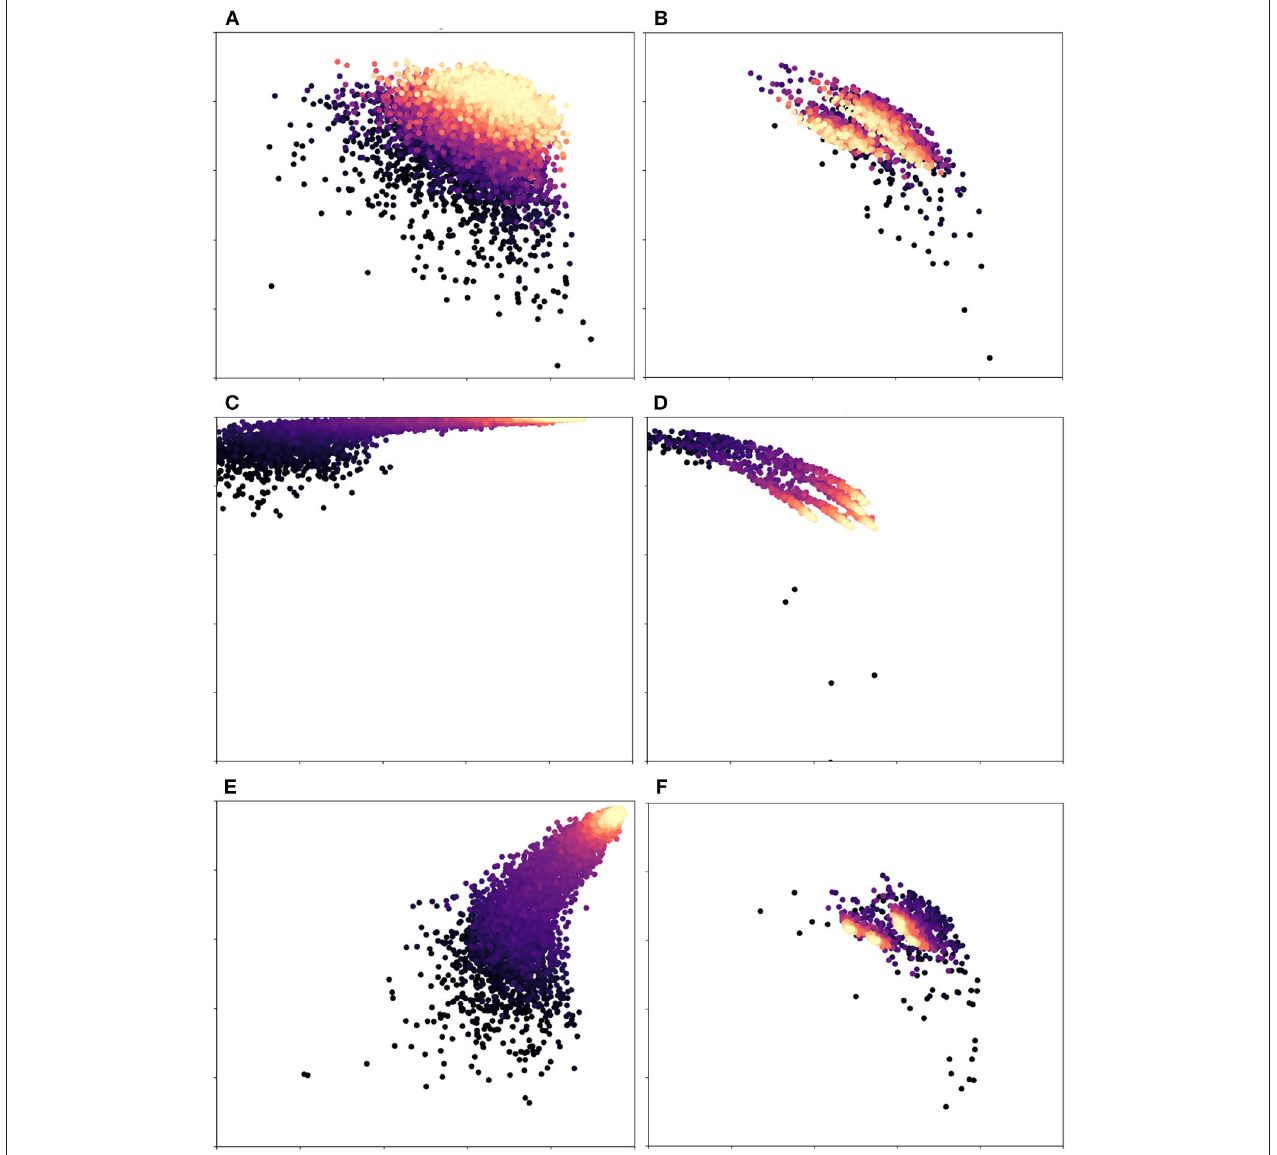
FIGURE 4 | Precision(x-axis) vs. Recall(y-axis) for different weight variations: Each dot represents an iteration of training/validation; darker circles indicate earlier iterations, while lighter/golden ones indicate later iterations. The first row (A,B) is our proposed pipeline, while the second (C,D) and third rows (E,F) are class-based weights (the ones used by the original U-net) and equal weights, resp. The left column is the training set, while the right column corresponds to the validation set. The scale of both axes is [0.5, 1.0] in all plots. Equal weights are biased toward recall and class-based weights overfit to the training set. Dynamic weights, however, achieve a robust balance of precision and recall. Figure best viewed in